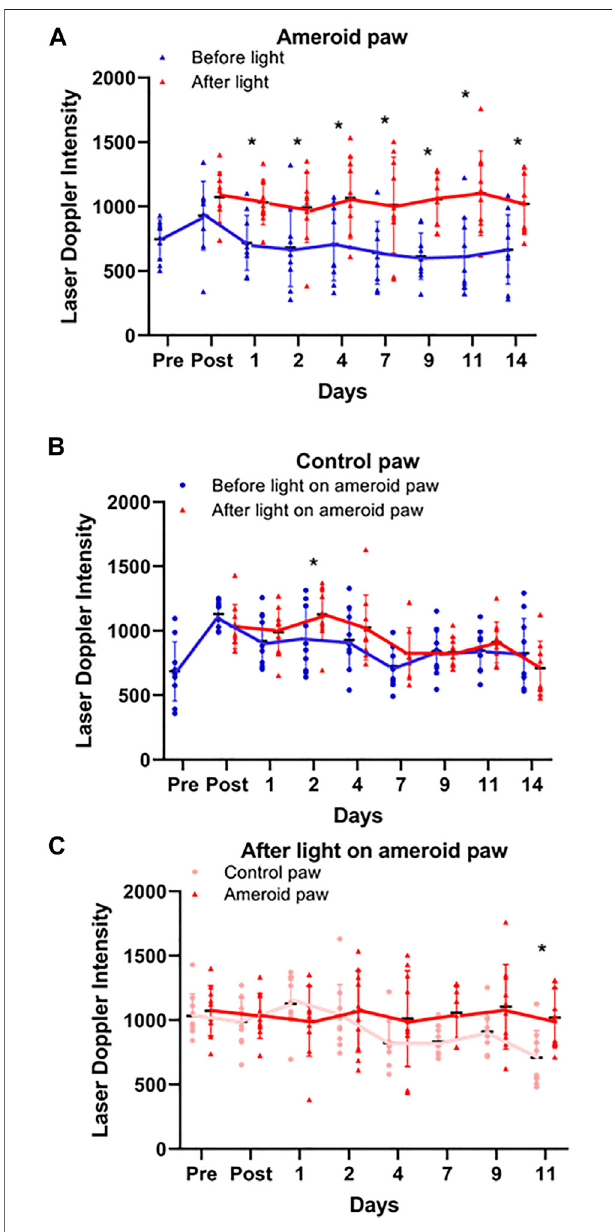
FIGURE 6 | Light effect on ameroid hindlimb ischemia. Doppler perfusion of the plantar foot was assessed pre and post-surgical implantation oftheameroidandfor14 dayspost-surgeryimmediatelybeforeandafterlight treatment. (A – C) Blood Flow measured by Laser Doppler Imaging before and after 670 nm light on ameroid paw: Ameroid paw (A) , Control paw (B) , and comparison ofboth paws after irradiation (C) . Mean± SDisdenoted. The adjusted P-values by the step-down Bonferroni procedure between control and ameroid are p = 0.165, 3.70 × 10 -15 , 1.25 × 10 -9 , 6.30 × 10 -14